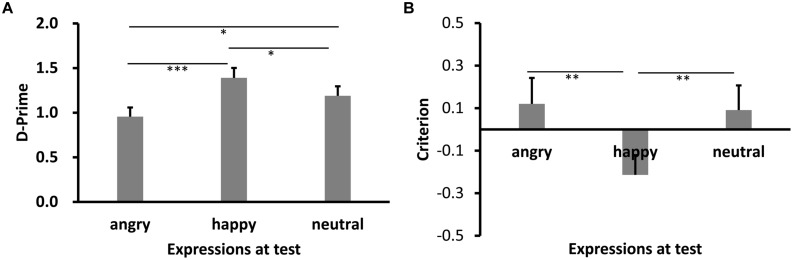
Sensitivity d′ (A) and Criterion c (B) results as a function of test expression (Experiment 2a). Error bars represent 1 SEM. ∗p < 0.05; ∗∗p < 0.01; ∗∗∗p < 0.001.